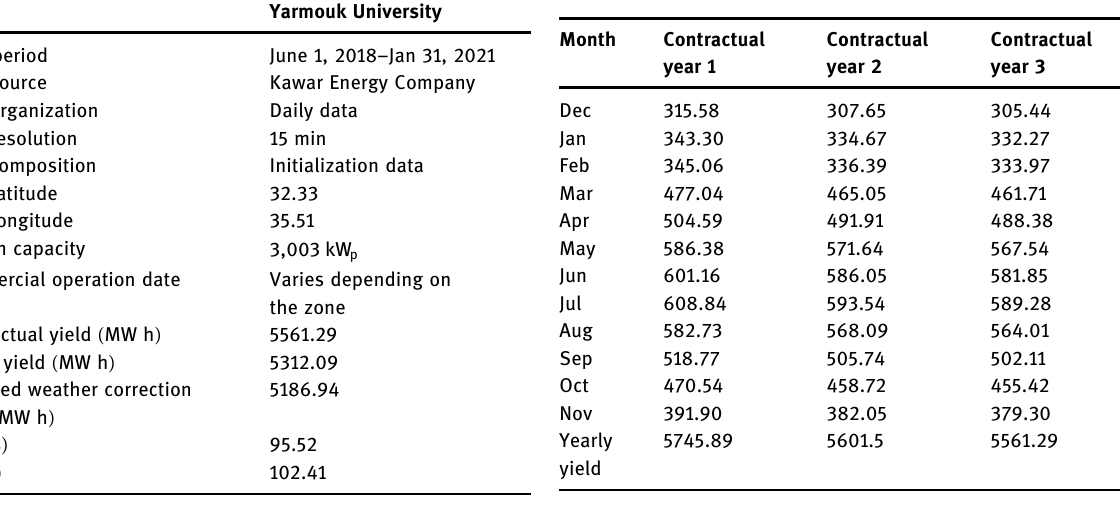
Table 1: Yarmouk University PV solar power plant information